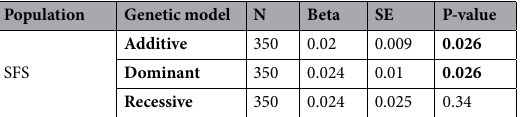
Table 6. Association analysis of the polymorphism rs6918289 with IMT-F in the discovery population (not available in the replication population). P-value threshold is P < 0.05 . Significant p-values are highlighted in bold.